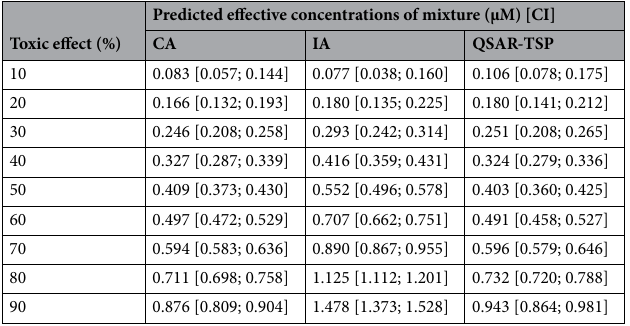
Table 1. Summary of predicted effective concentrations of mixture for Case Study 1.